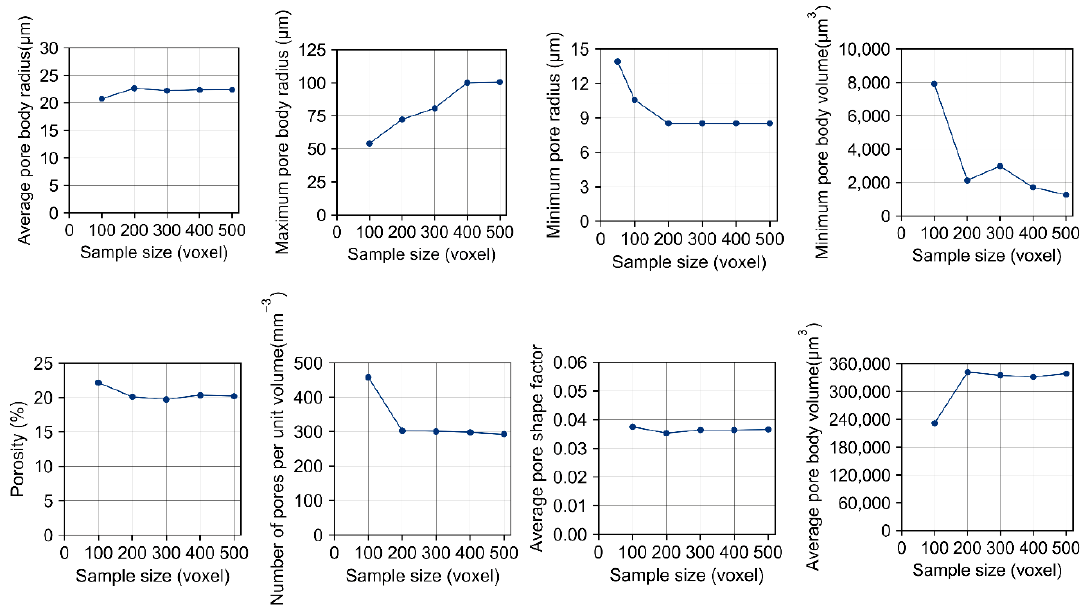
Figure 4. Pore network parameters of Gildehauser sandstone sample at di ff erent sizes of sub-volumes.